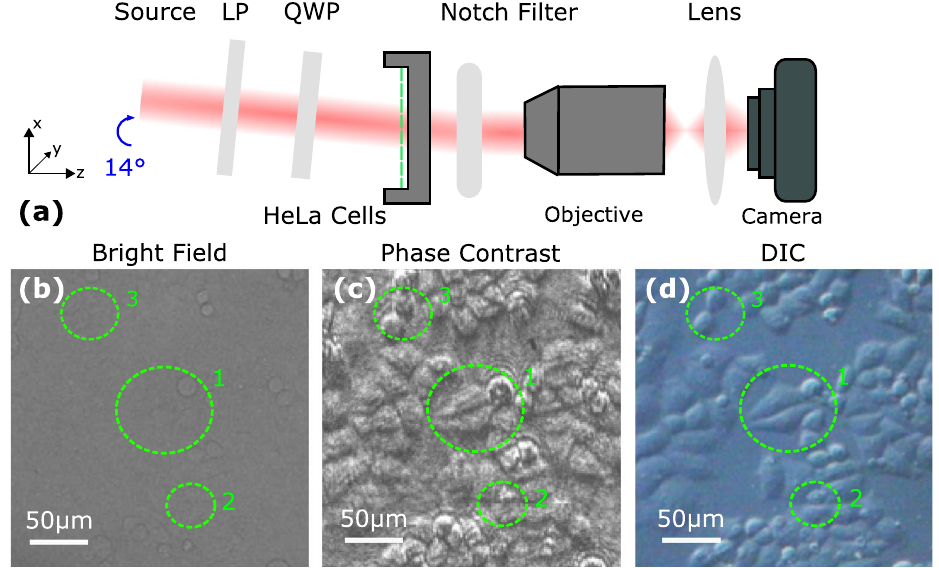
Figure 5. Biological phase imaging was performed using the experimental schematic in ( a ). The dashed line represents the HeLa cells within a petri dish and the schematic is not to scale. A bright field image of the HeLa cells obtained without the notch filter is given in ( b ). The corresponding phase contrast image obtained using the filter is given in ( c ) and a differential interference contrast image in ( d ). The dashed circles shown in ( b )–( d ) highlight regions where contrast was significantly enhanced for comparative